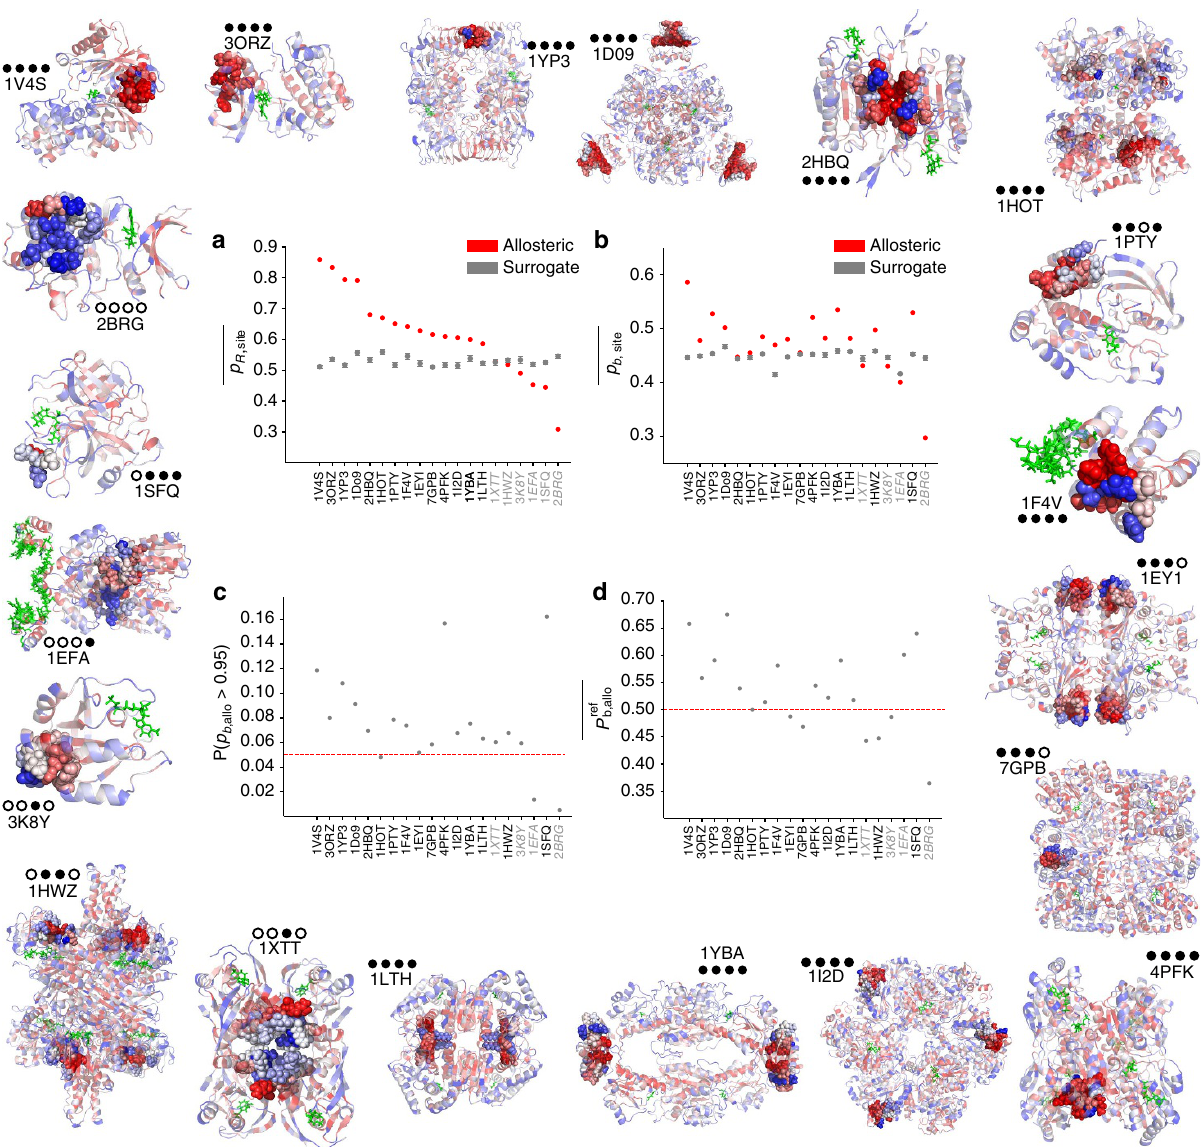
Figure 7 | Prediction of allosteric sites based on bond-to-bond propensity for a test set of 20 allosteric proteins. The structures of the 20 proteins in the test set (labelled by PDB code) have their residues coloured by their quantile score p R , and the allosteric site is shown as spheres. For full details of these proteins, see Supplementary Table 2. The four statistics computed from our propensity are showed in the centre: ( a ) average residue quantile scores in the allosteric site p R ; allo (red) compared with the average score of 1,000 surrogate sites p R ; site (cid:4) (cid:5) (grey), with a 95% confidence interval for the average from surr a bootstrap with 10,000 resamples (see ‘Structural bootstrapping’); ( b ) average ‘bond’ quantile scores in the allosteric site against the equivalent bootstrap of 1,000 surrogate sites; and ( c ) tail of the distribution of bond propensities, that is, proportion of allosteric site bonds with quantile scores p b ,allo 4 0.95. Proteins above the expected proportion of 0.05 (red line) have a larger than expected number of bonds with high quantile scores; ( d ) average ‘reference’ . The red dotted line indicates the expected value of 0.5, and proteins above this line have a higher than bond quantile score in the allosteric site p ref b ; allo expected reference quantile score. For the numerical values of all measures see Supplementary Table 3. The four circle code by each protein indicates whether the allosteric site is identified (filled circle) or not identified (open circle) according to each of the four measures ( a – d ). Nineteen out 20 allosteric sites are identified by at least one measure, and 15 out of 20 sites are identified by at least three of four